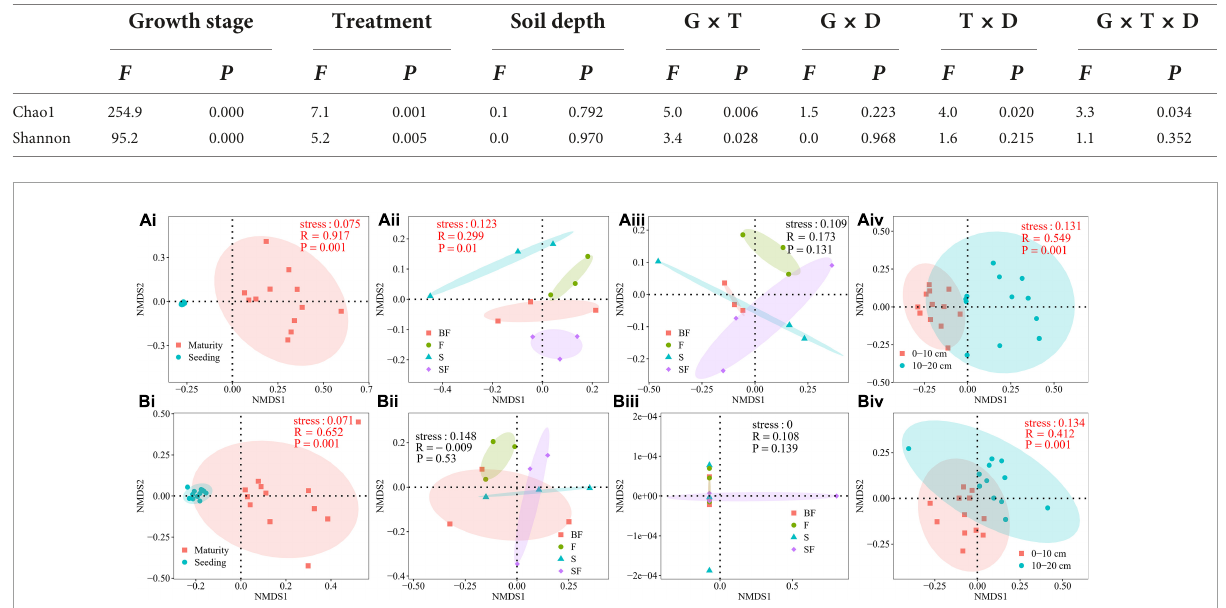
TABLE 2 Summary of three-way ANOVAs results for bacterial alpha diversity.